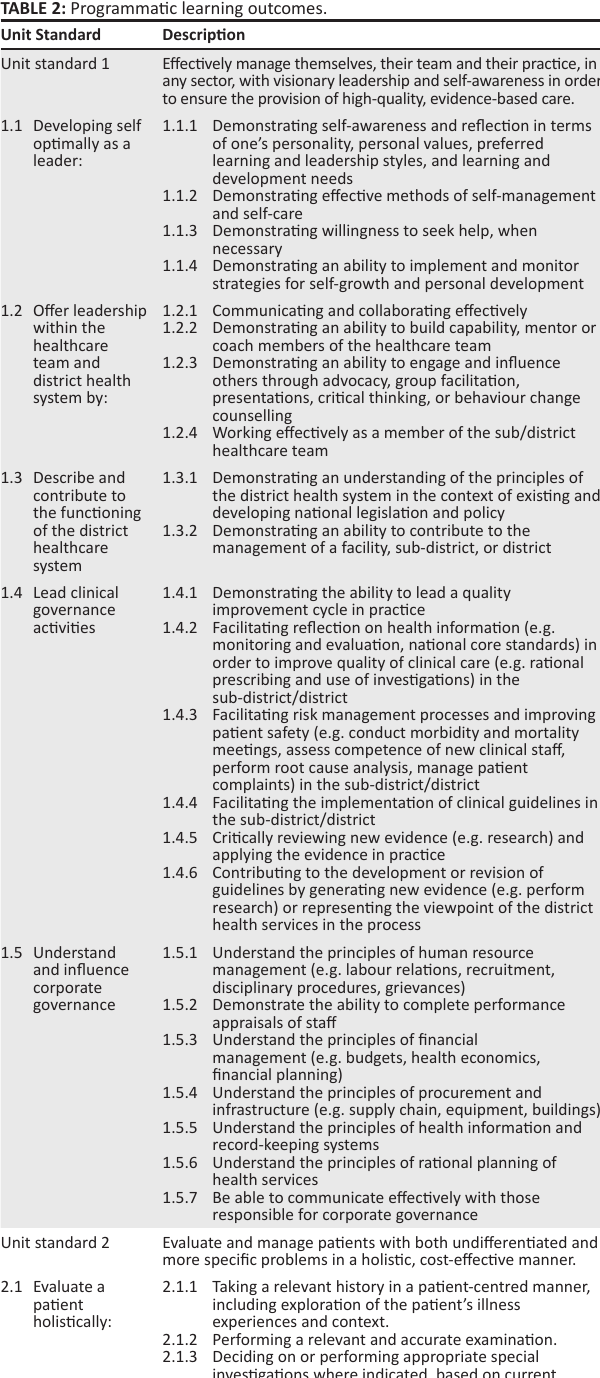
TABLE 2: Programmatic learning outcomes.